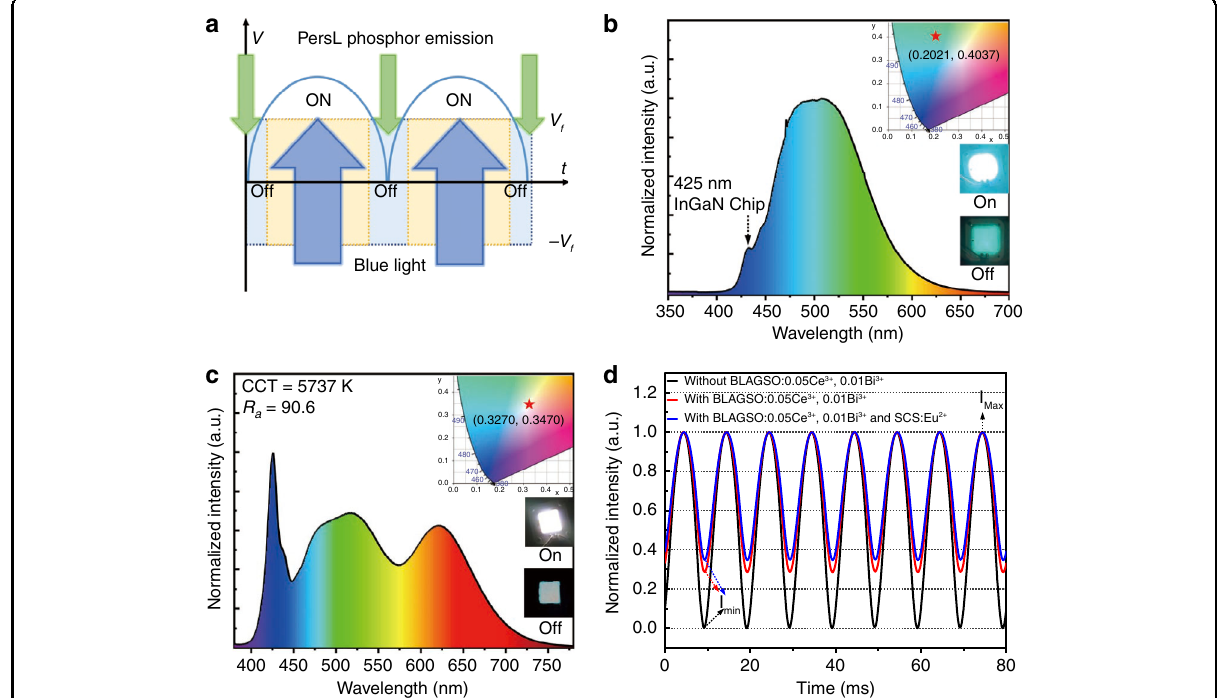
Fig. 8 AC-LED applications for BLAGSO:Ce 3 + , Bi 3 + . a The scheme of AC fl icker compensation using PersL phosphors. b EL spectrum of BLAGSO:0.05Ce 3 + , 0.01Bi 3 + . Inset: the CIE chromaticity coordinate and AC-LED device images on and off states. c EL spectrum of the white AC-LED fabricated by commercial orange-red PersL phosphor SCS:Eu 2 + , as-prepared phosphor BLAGSO:0.05Ce 3 + , 0.01Bi 3 + , and a 425 nm InGaN chip. Inset: the CIE chromaticity coordinate and AC-LED device images on and off states. d Luminescence intensity variation during AC